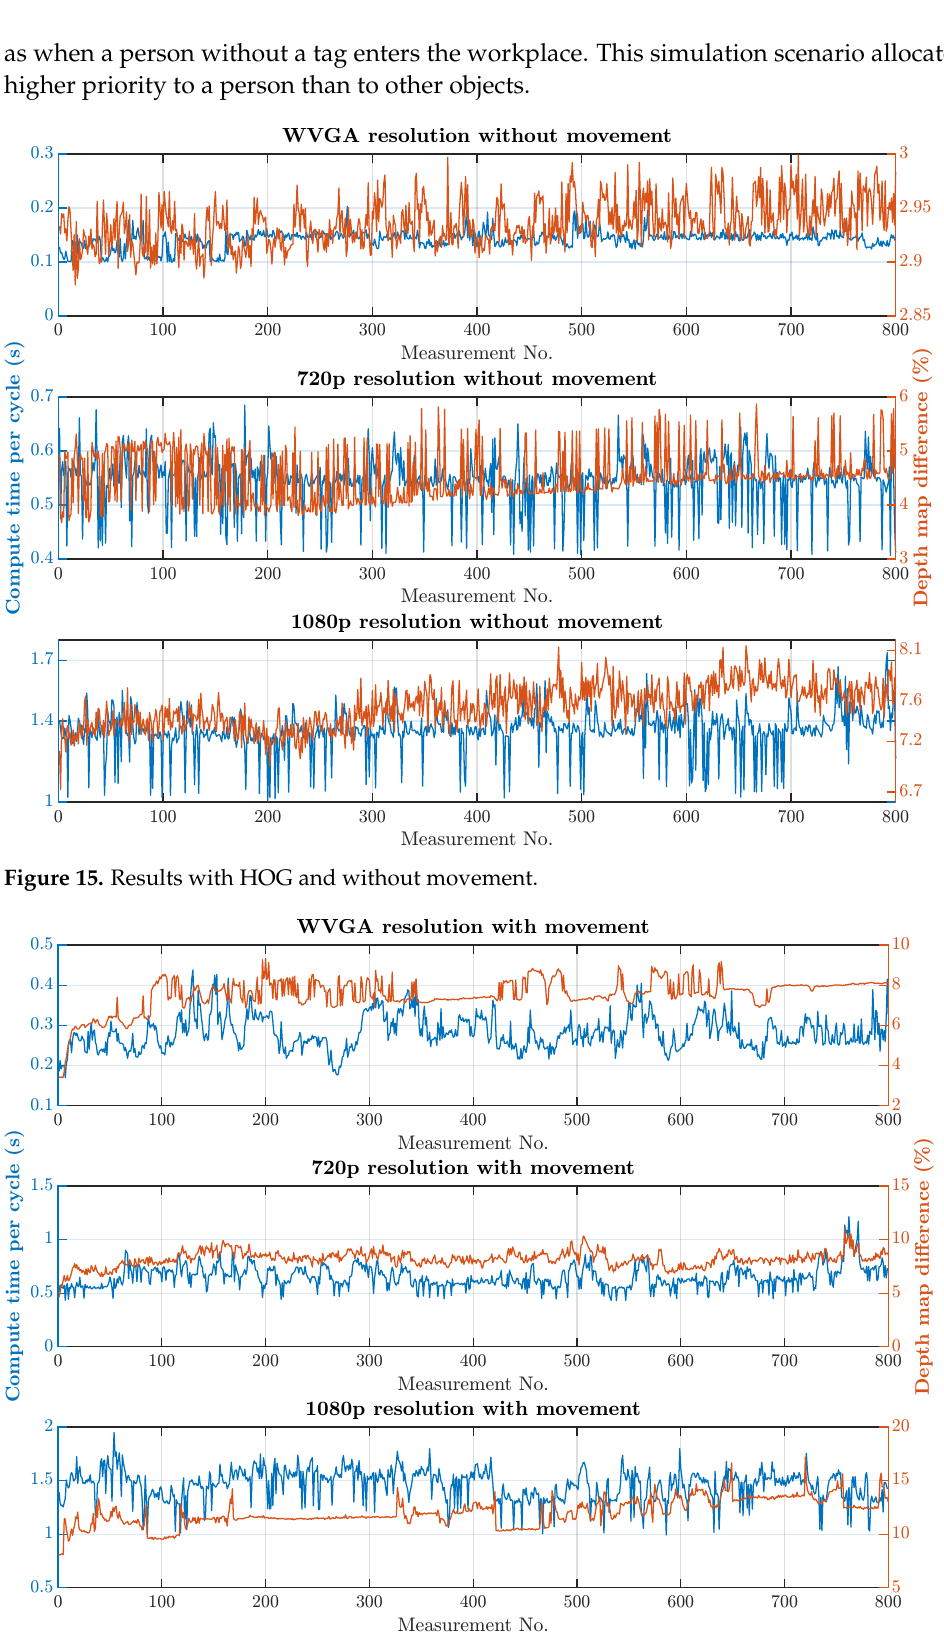
Figure 16. Results with HOG and with movement. Both scenarios were tested for the presence of multiple people or trolleys at the same time. The algorithm can identify several objects simultaneously. The more objects there